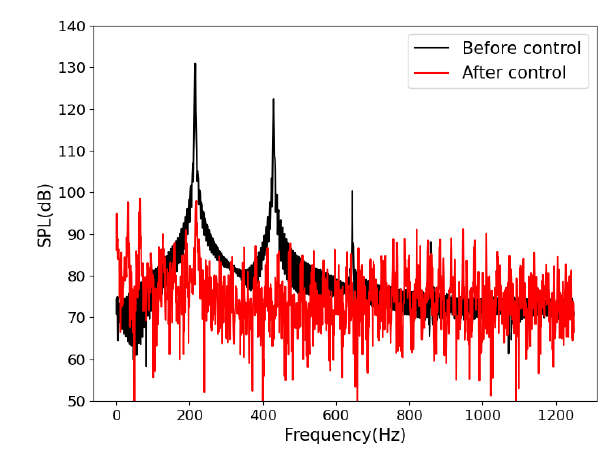
Figure 9. THA oscillation with and without discharge.